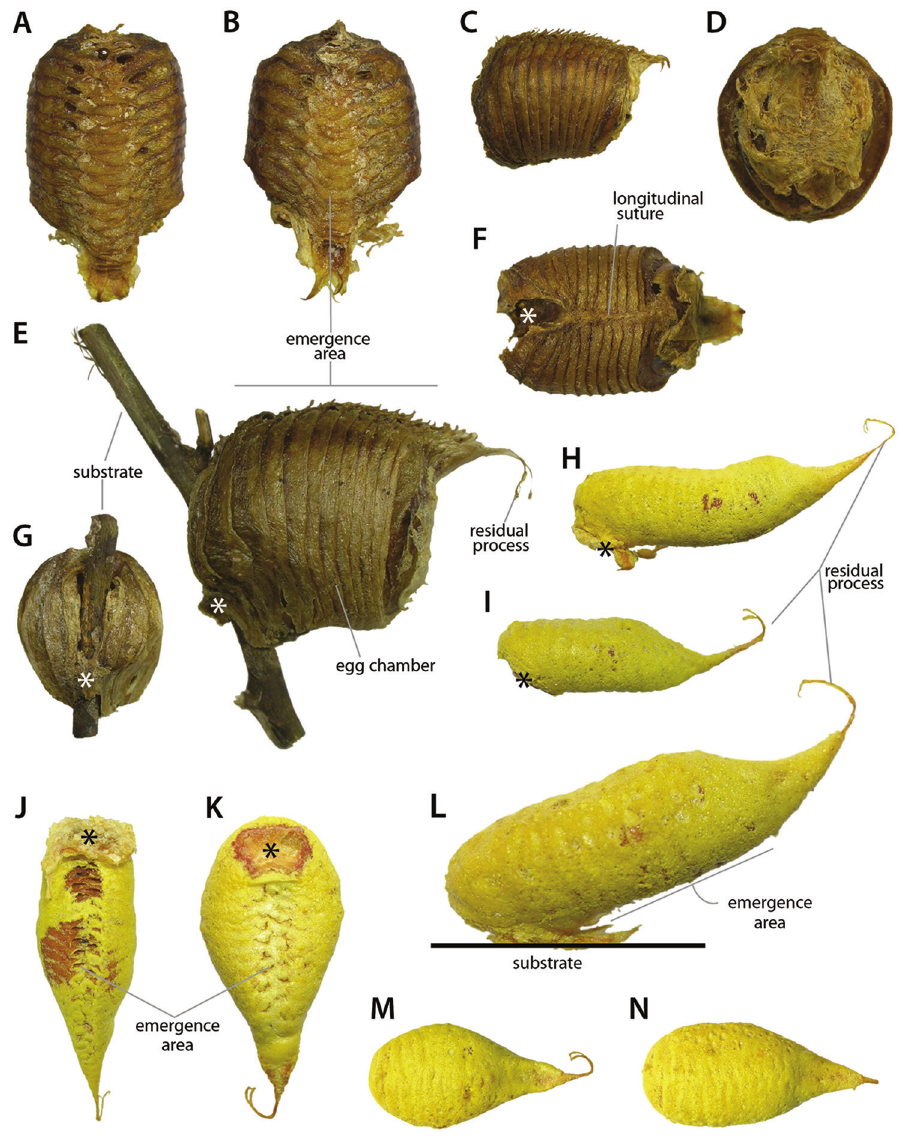
Figure 21. Oothecae of Stagmatoptera supplicaria Burmeister, 1838 and Callibia diana Stoll, 1813.